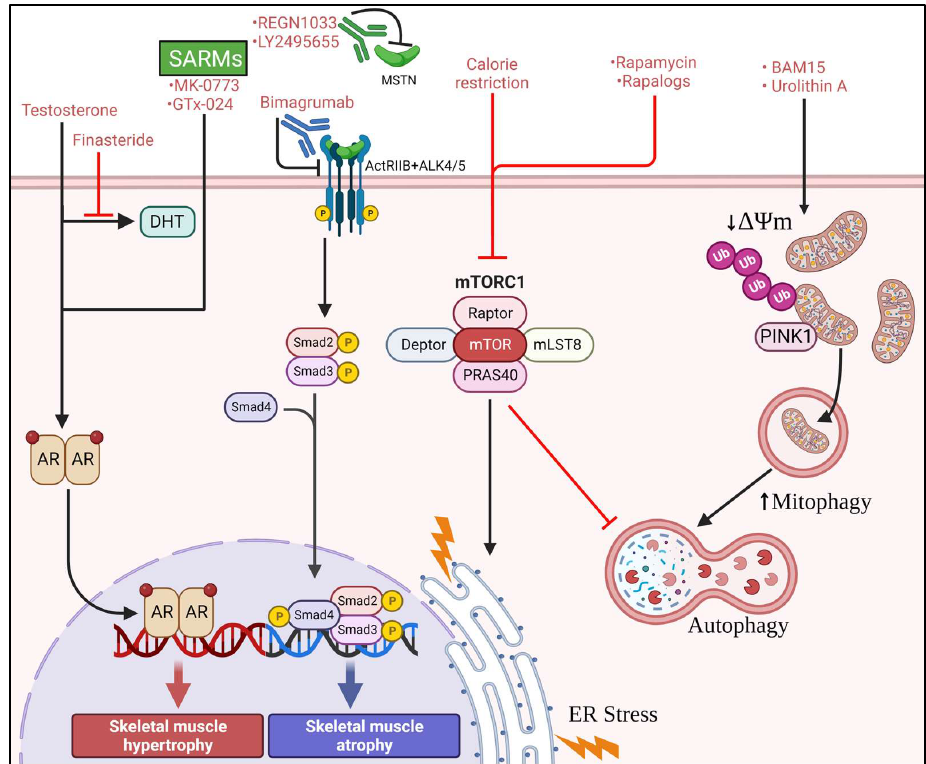
Figure 4. Potential therapeutic interventions to treat sarcopenia. Calorie restriction, rapamycin, and rapalogs can enhance skeletal muscle quality through inhibition of mTORC1 signaling and enhancement of autophagy and cellular quality control mechanisms. Administration of BAM15 and urolithin A improves muscle mass and quality in sarcopenic obesity through depolarization of mitochondria and subsequent mitophagic clearance, thereby dynamically maintaining the health of the mitochondrial pool. Testosterone and SARMs improve skeletal muscle mass through androgen receptor (AR)-mediated mechanisms, while finasteride is used to diminish androgenic signaling by inhibiting dihydrotestosterone (DHT) production. Antibodies used to target both myostatin (MSTN) or the activin type II receptor inhibit myostatin-mediated signaling upstream of SMAD2/3, thereby reducing catabolic gene expression and facilitating skeletal muscle anabolism.